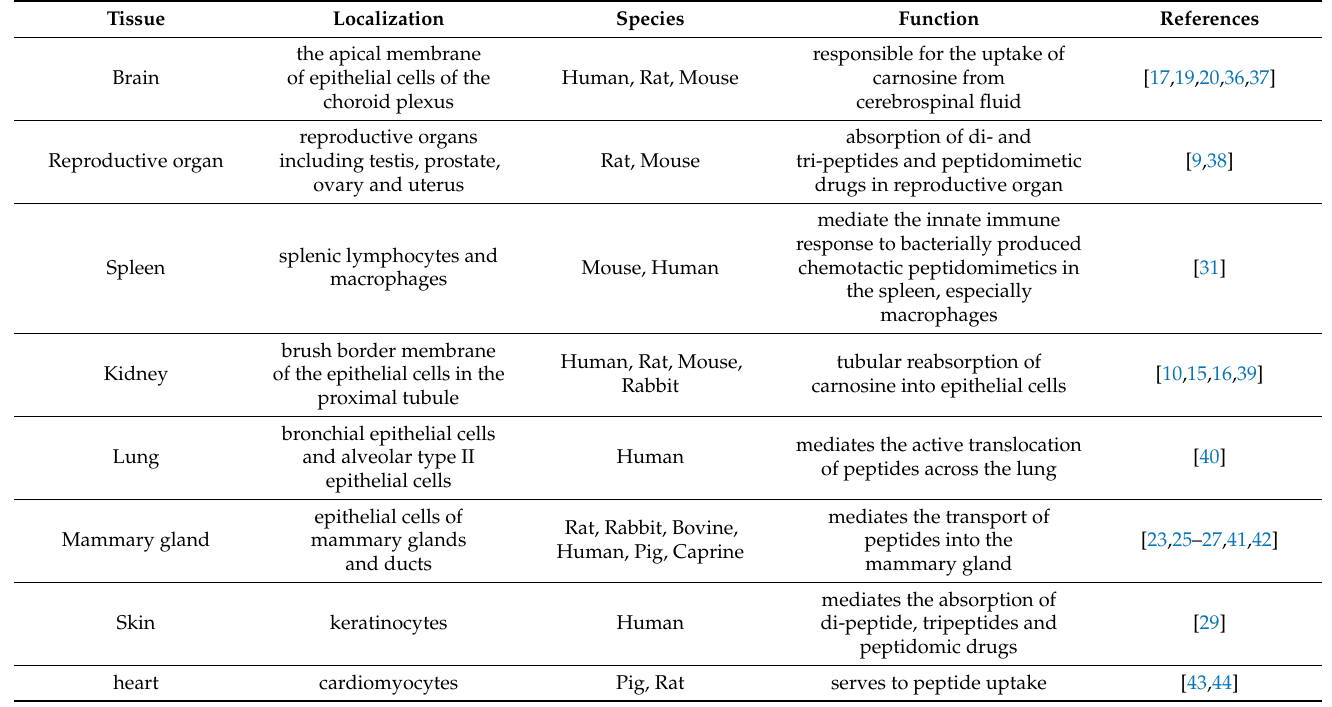
Table 1. Localization and function of